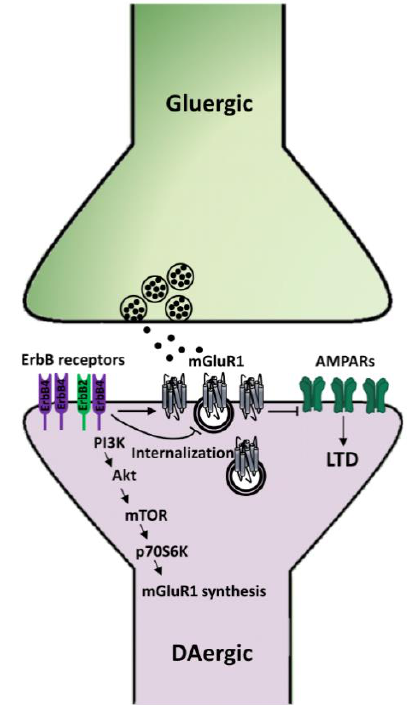
Figure 5. Mechanisms underlying NRG1/ErbB-dependent regulation of mGluRI-LTD in midbrain DA neurons. NRG1-dependent activation of ErbB receptors in SNpc DA neurons induces the synthesis of mGluR1 receptors, thus fostering mGluR1-LTD of AMPARs-mediated transmission, whereas inhibition of endogenous ErbB signaling causes mGluR1 internalization and consequent impairment of